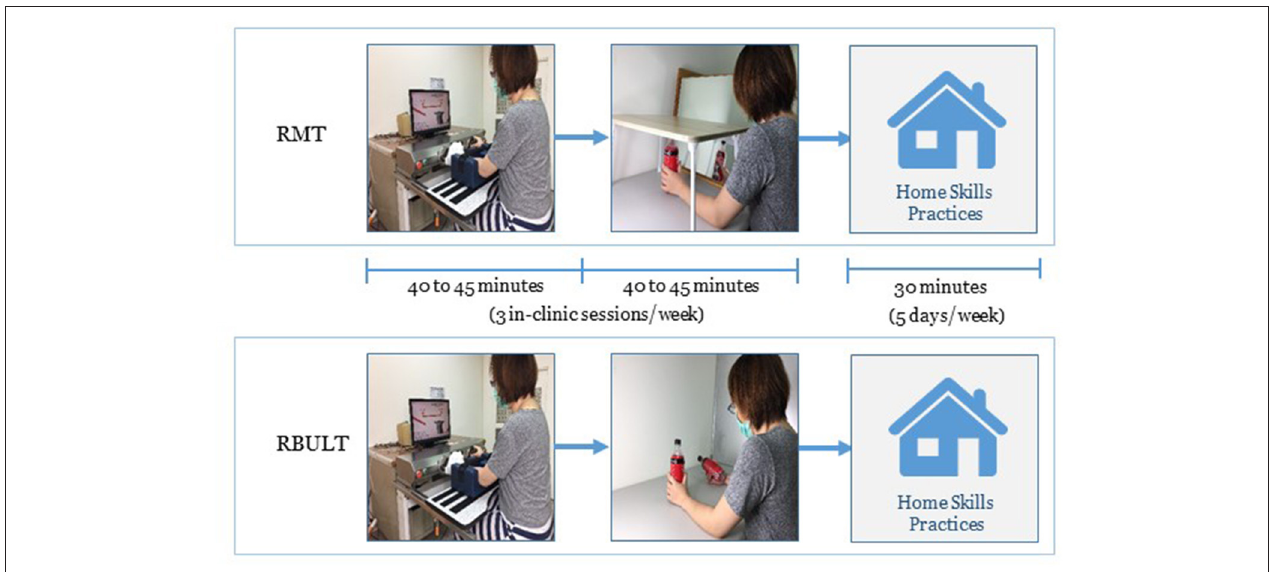
FIGURE 3 | Diagram of the study design.